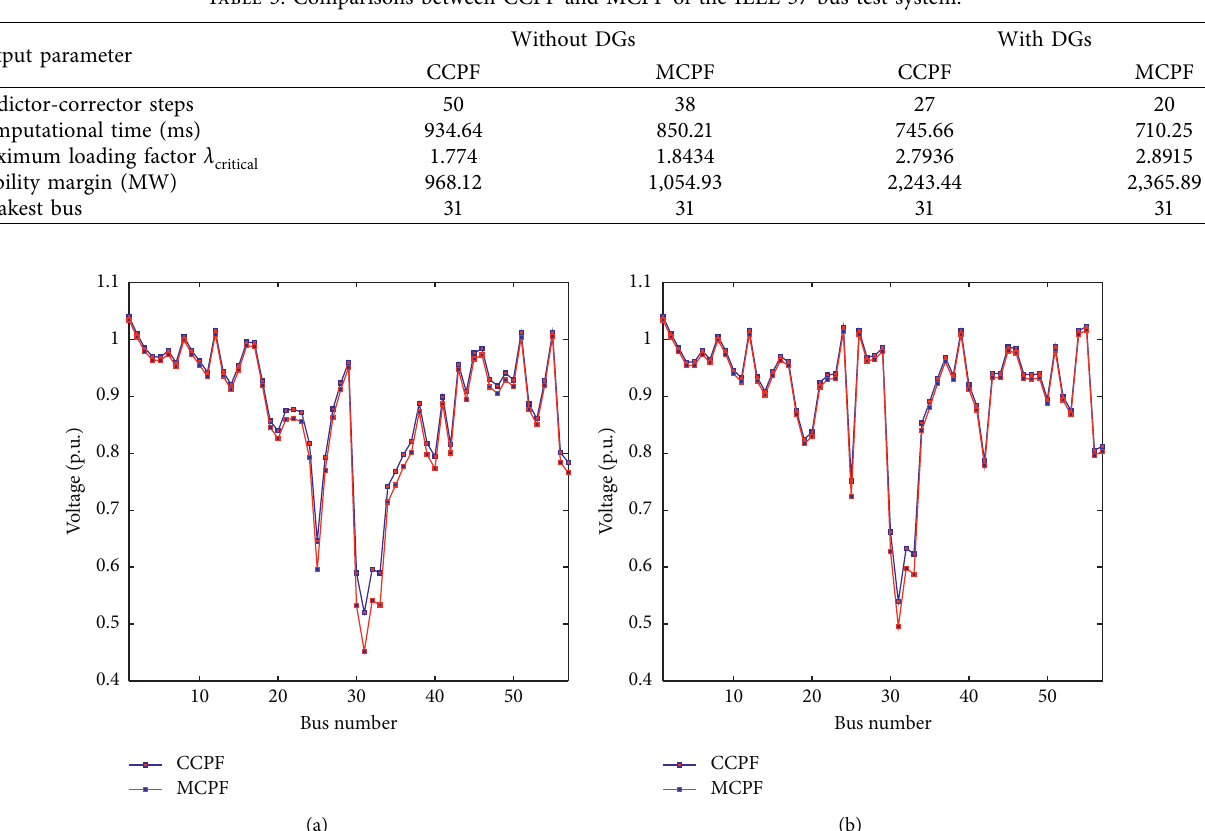
Figure 9: Voltage profile of the 57-bus system buses: (a) without DG at buses 26, 39, and 54; (b) with DG at buses 26, 39, and 54.